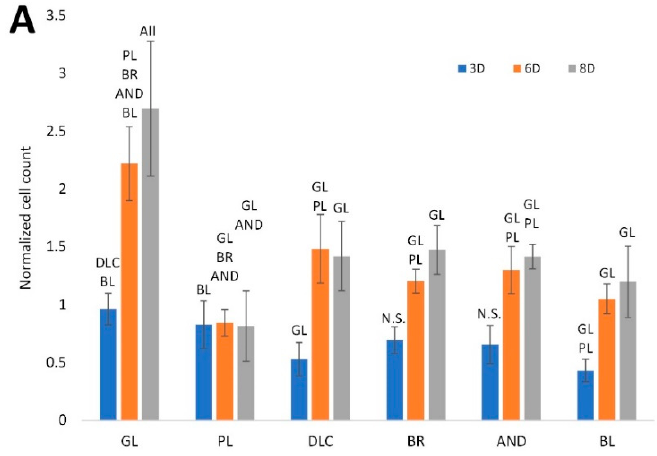
Table 2. The relative elemental composition in the surface layer of Ti6Al4V, grade 5 ELI, modified by polishing (PL), by DLC-coating (DLC), by brushing (BR), by anodizing (AND), or by blasting (BL), calculated from